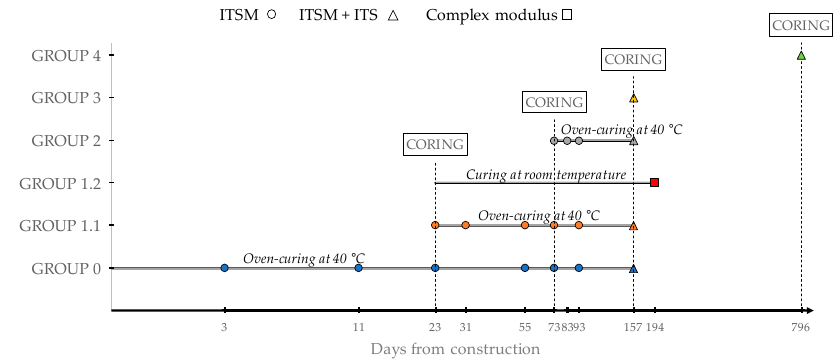
Figure 7. Experimental program.